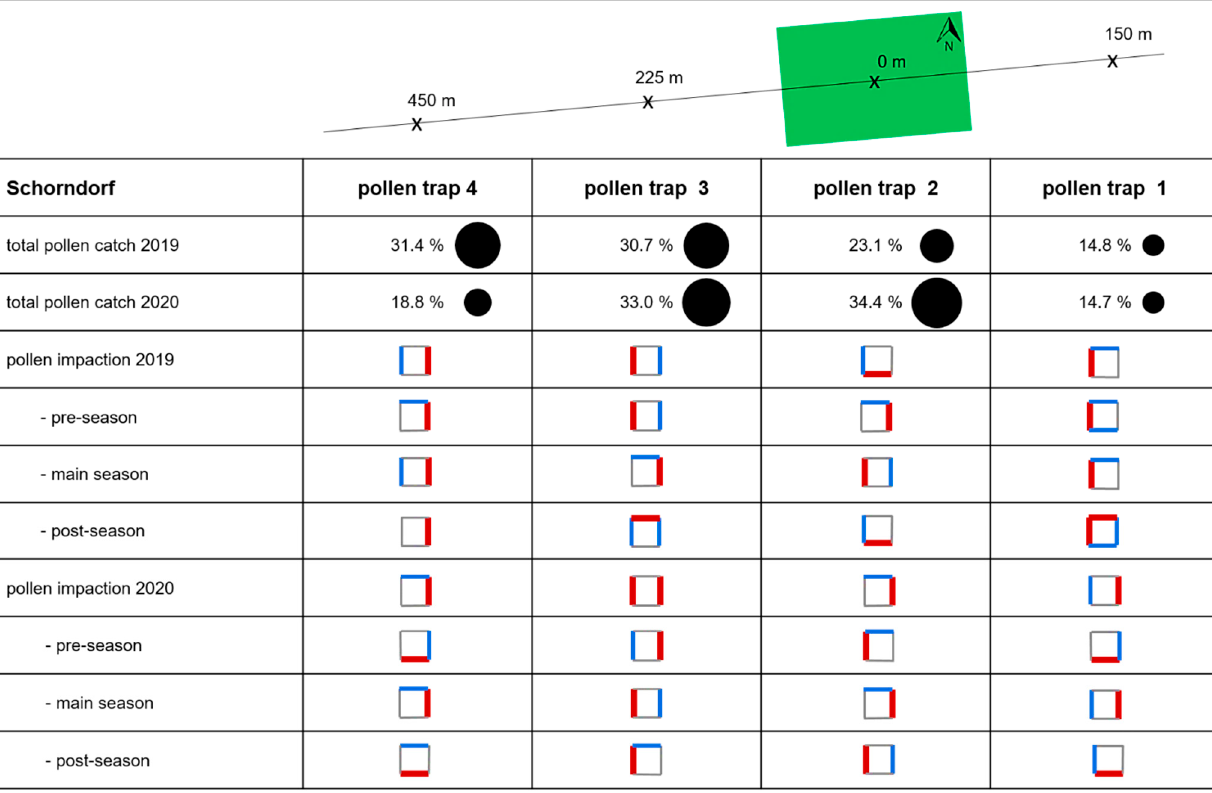
Figure 5. Pollen measurements obtained for the study site Schorndorf. The location of traps (marked with an “x”) and of the plantation (green rectangle) are highlighted at the top of the table. For pollen catch, the size of the circles represents the order of the amount of pollen measured. For pollen impaction, the square represents the pollen trap, the red thick dashes indicate the direction where the most pollen was recorded, and the blue dashes show where the second most pollen was recorded.